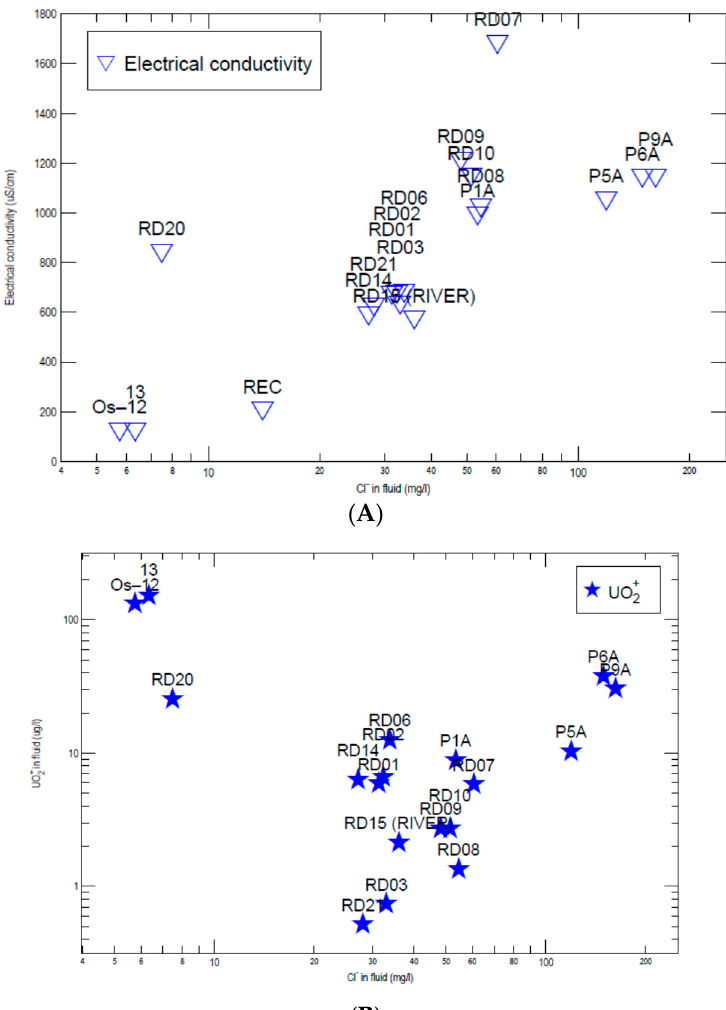
Figure 5. Evolution of electrical conductivity ( A ) and U ( B ) against chloride concentration. Table 3. Main anion contents of water samples.